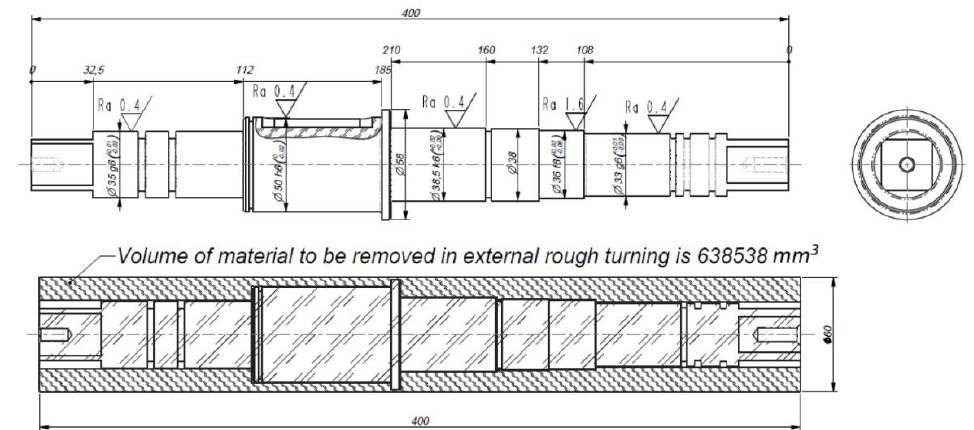
Figure 1. The shaft geometry and the volume of workpiece material to be removed by rough external